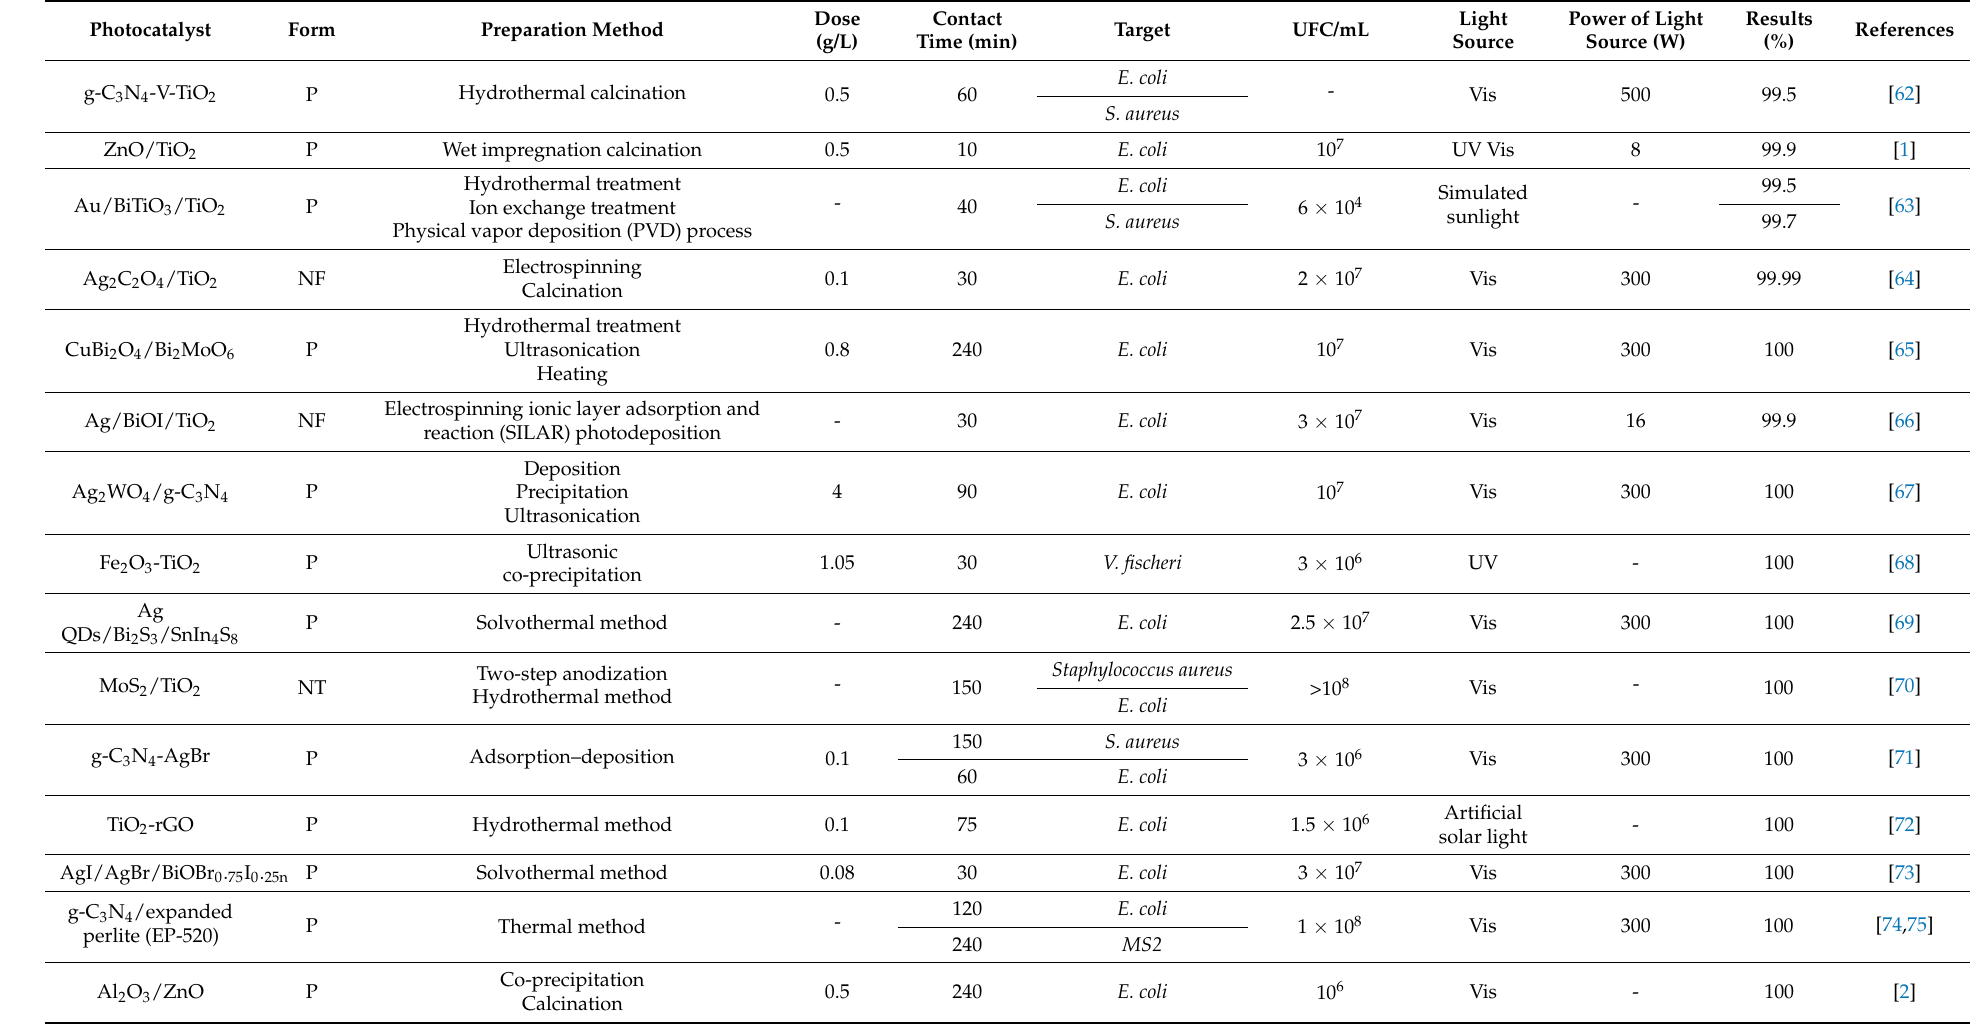
Table 1. Heterostructured photocatalysts used for microorganism